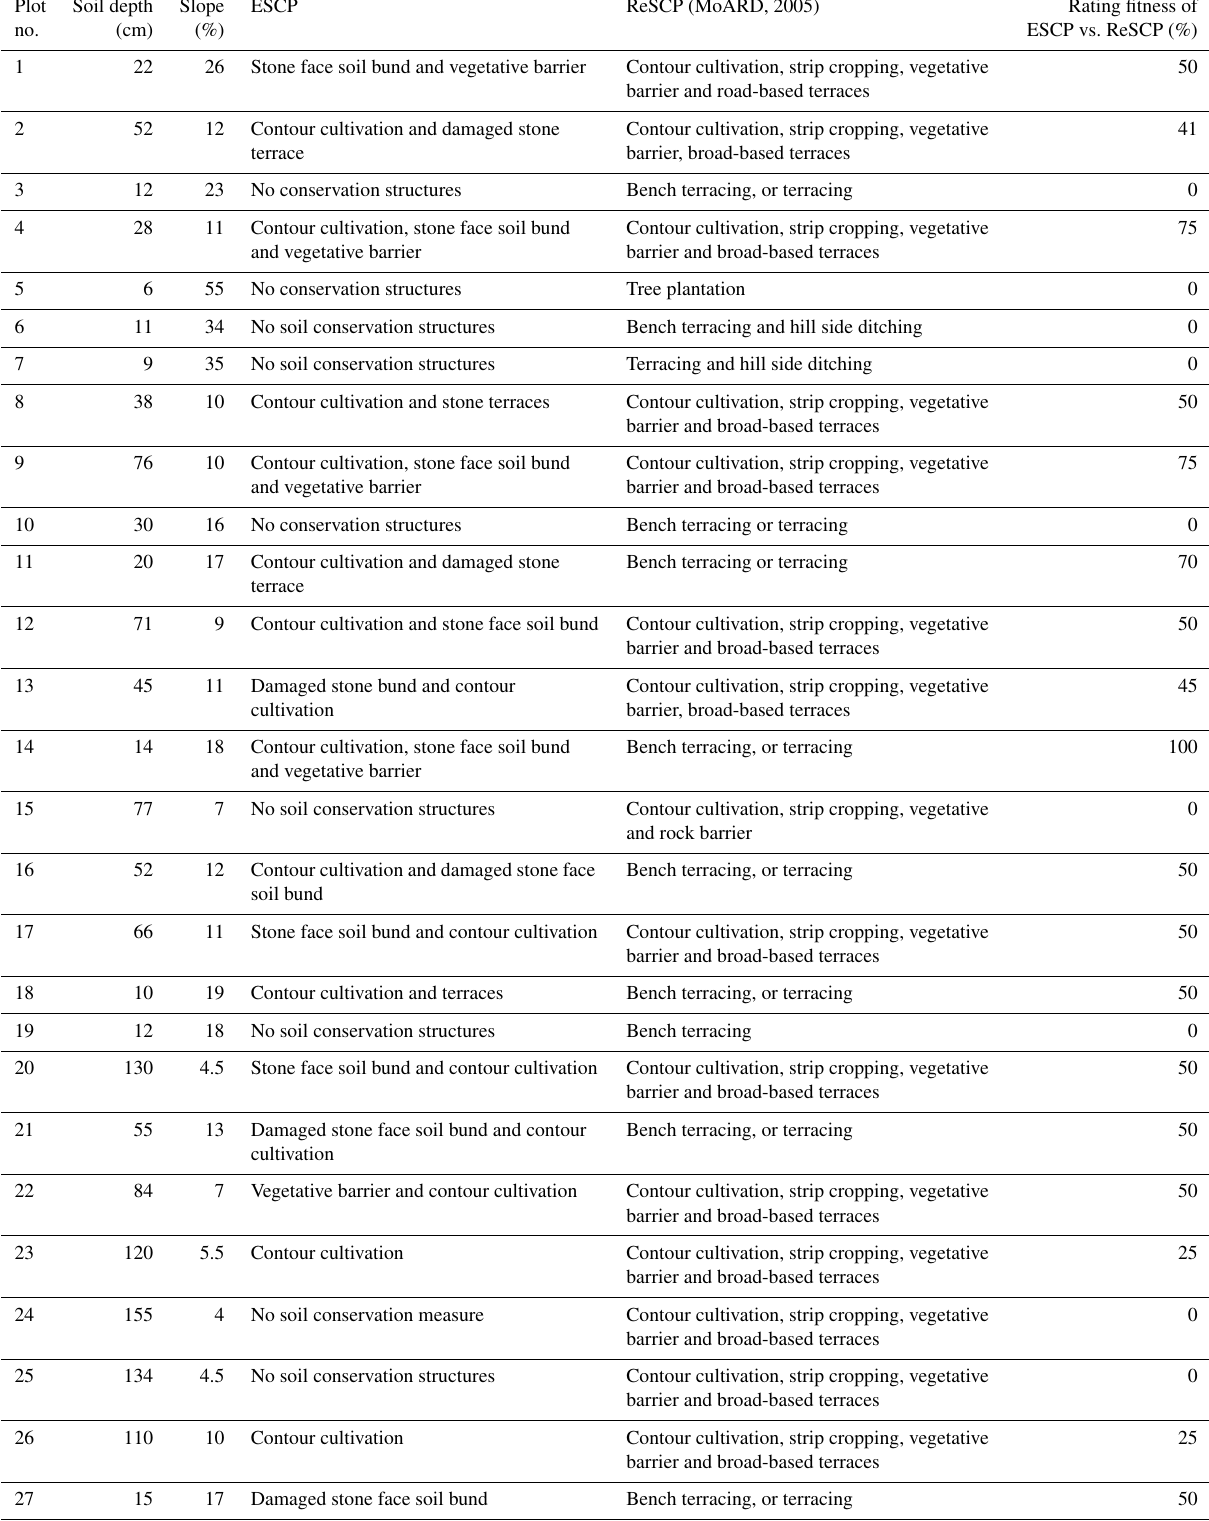
Table 4. Evaluation of the status of existing soil conservation practices (ESCP) based on the national recommended soil conservation practices (ReSCP), considering the soil depth and slope value of selected farm plots during the study period. Plot Soil